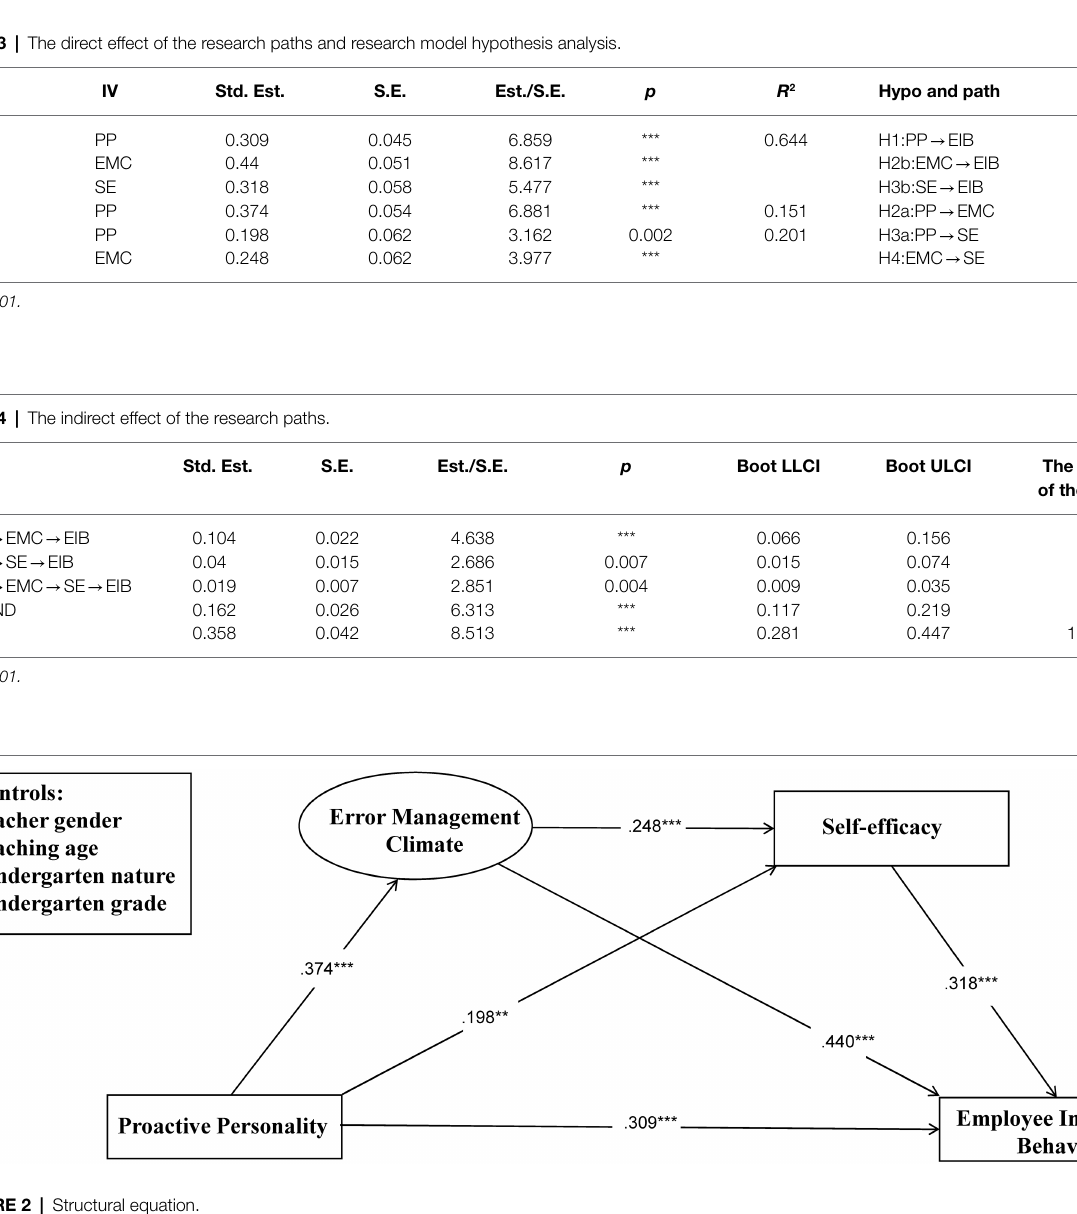
TABLE 3 | The direct effect of the research paths and research model hypothesis analysis. DV IV Std. Est.